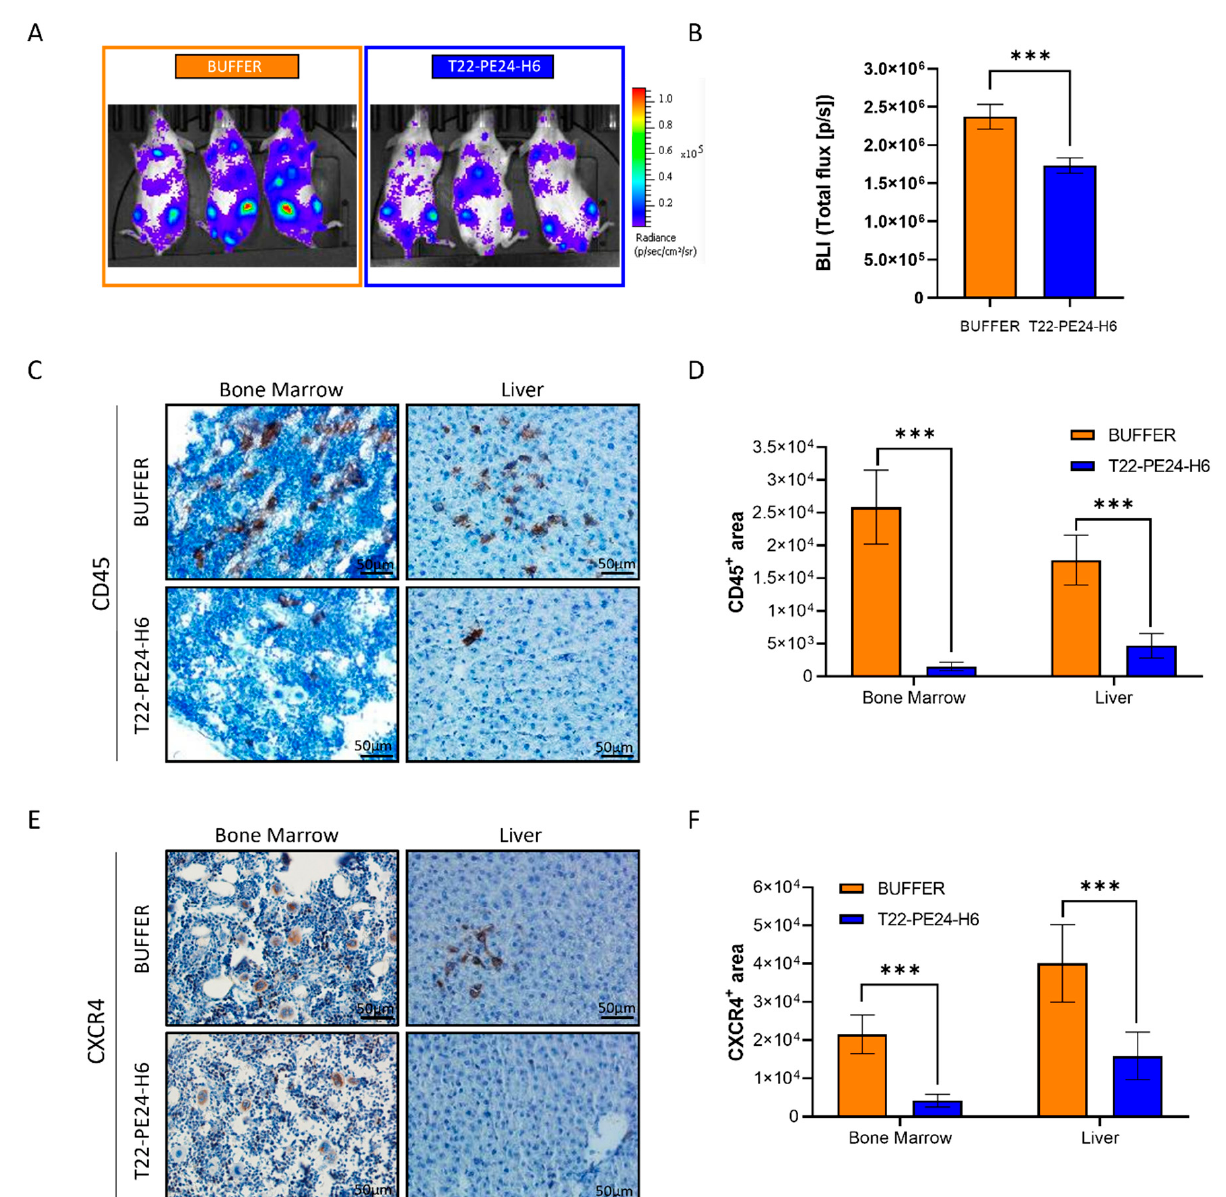
Figure 3. T22-PE24-H6 antineoplastic effect in a CXCR4 + AML disseminated mouse model. ( A ) Representative bioluminescent images of mice treated with buffer (NaCO3H + NaCl pH = 8) or 5 µg T22-PE24-H6 after 10 doses. ( B ) BLI at day 12 after MONO-MAC-6-Luci cell injection, comparing the BUFFER and T22-PE24-H6 mouse groups. ( C ) Anti-human CD45 staining representative images, and ( D ) quantification of leukemic cells in the BM and liver of mice treated with buffer or T22-PE24- H6. ( E,F ) Detection and quantification of CXCR4 levels, by IHC, in the BM and liver of the leukemic mice 14 days after i.v. injection of MONO-MAC-6-Luci cells. The results are presented as mean of staining area ± SEM. Statistical analysis was performed using the T-test or Mann-Whitney U test, and significant differences between the groups are indicated as *** p ≤ 0.005. Original magnification × 400 for panels A and C. BLI: bioluminescence